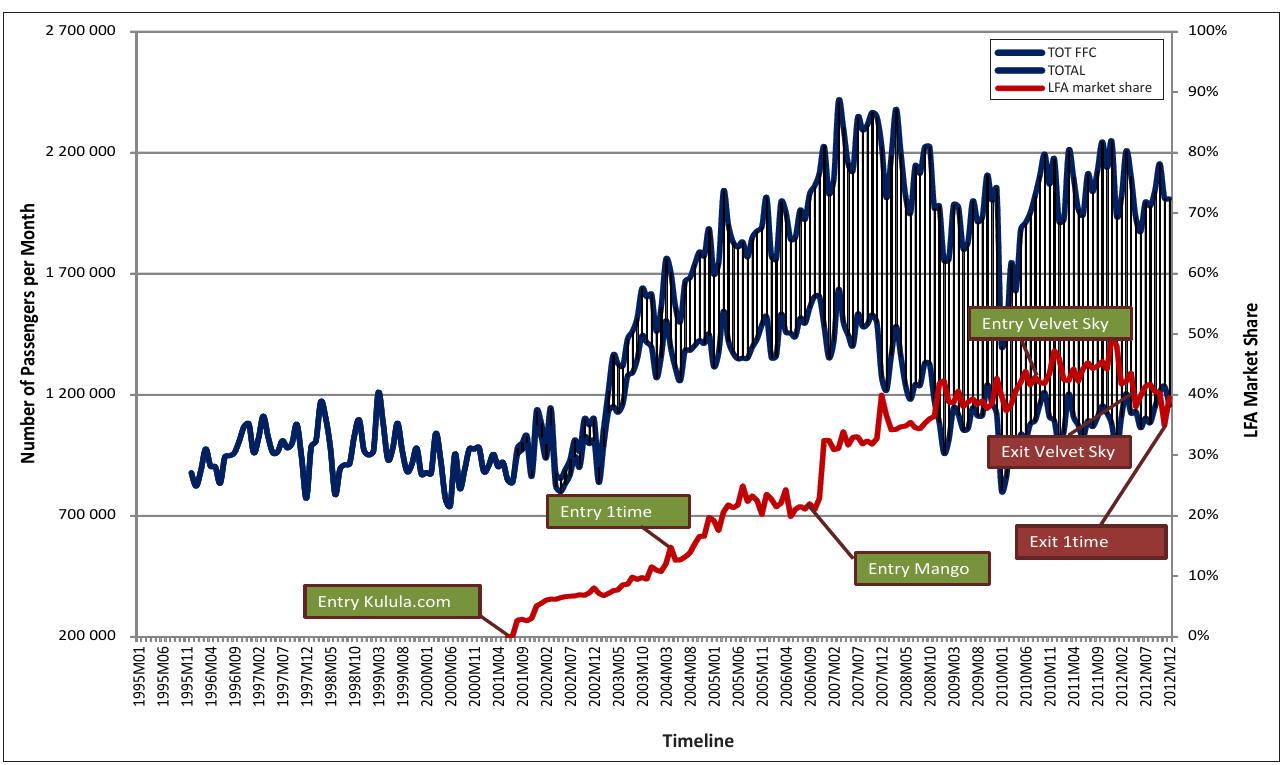
FIGURE 3: Load factors on the ‘Golden Triangle’ (total scheduled domestic arrivals and departures).